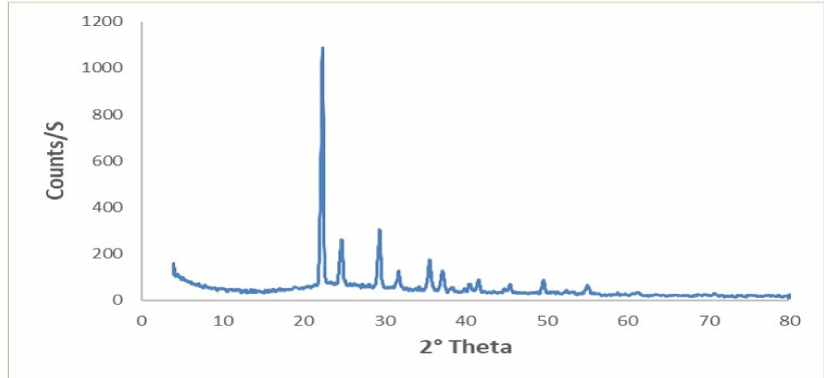
Figure 1. X-ray diffraction patterns of CS–urea NC.